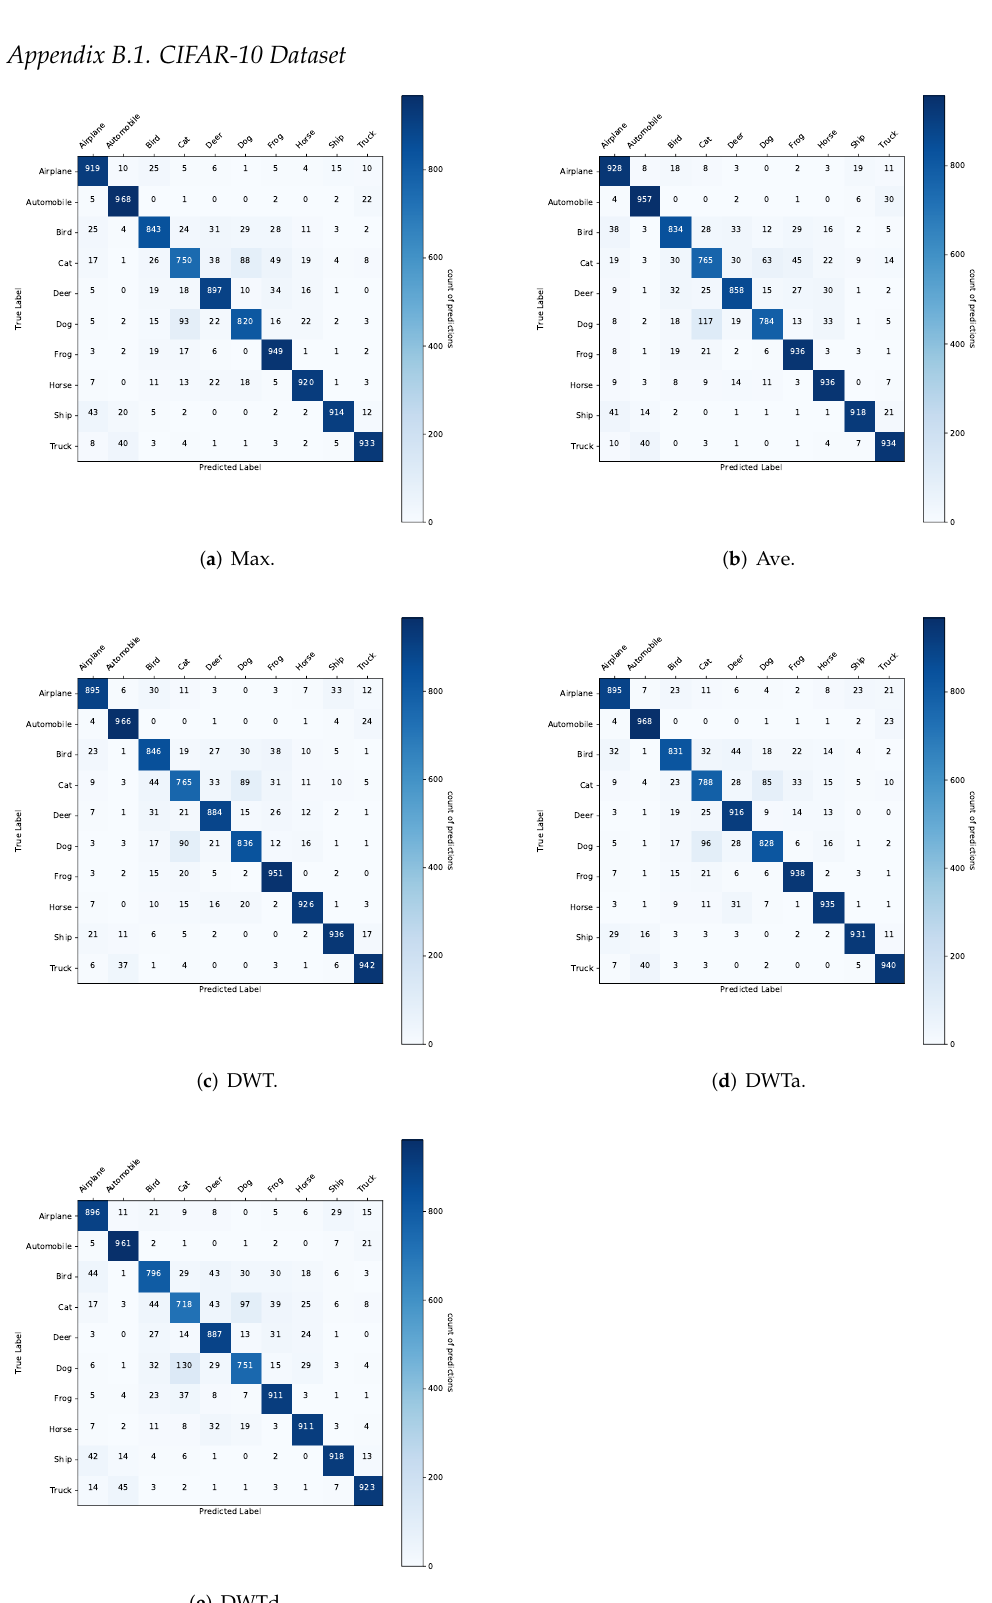
Figure A3. In this case, each confusion matrix correlates with the five models obtained for the CIFAR-10